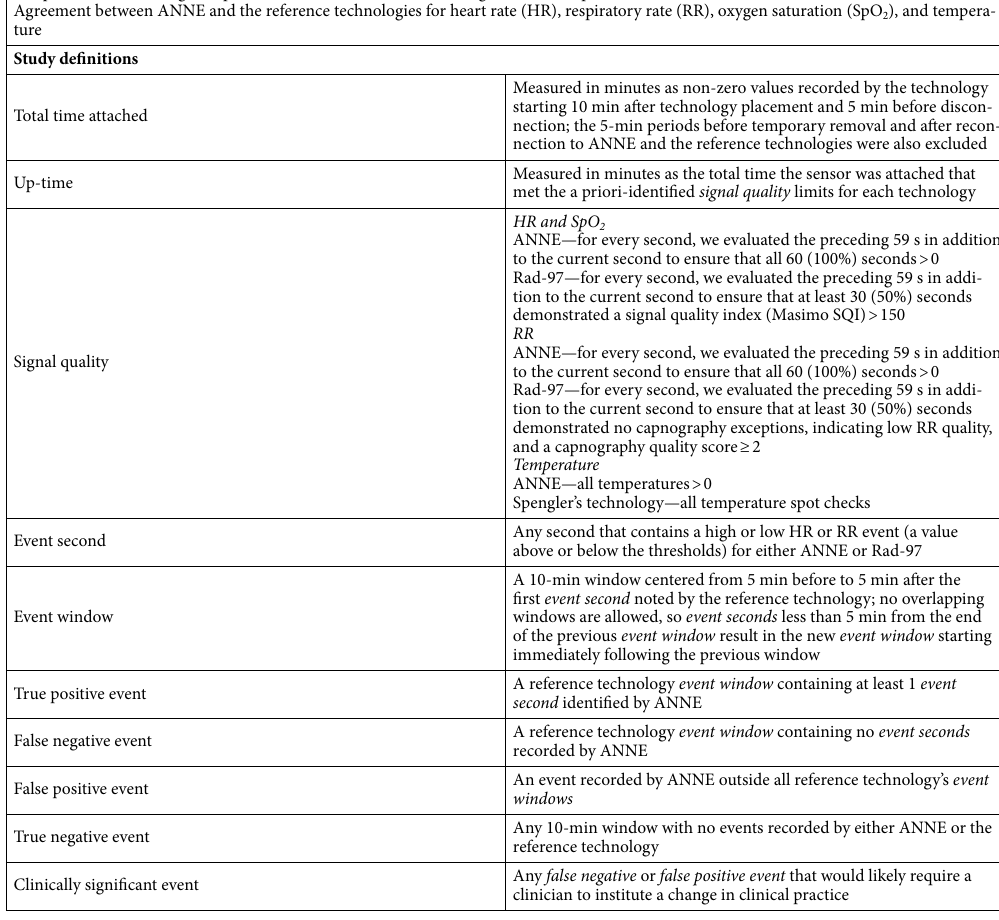
Table 1. Study eligibility criteria, endpoints, and